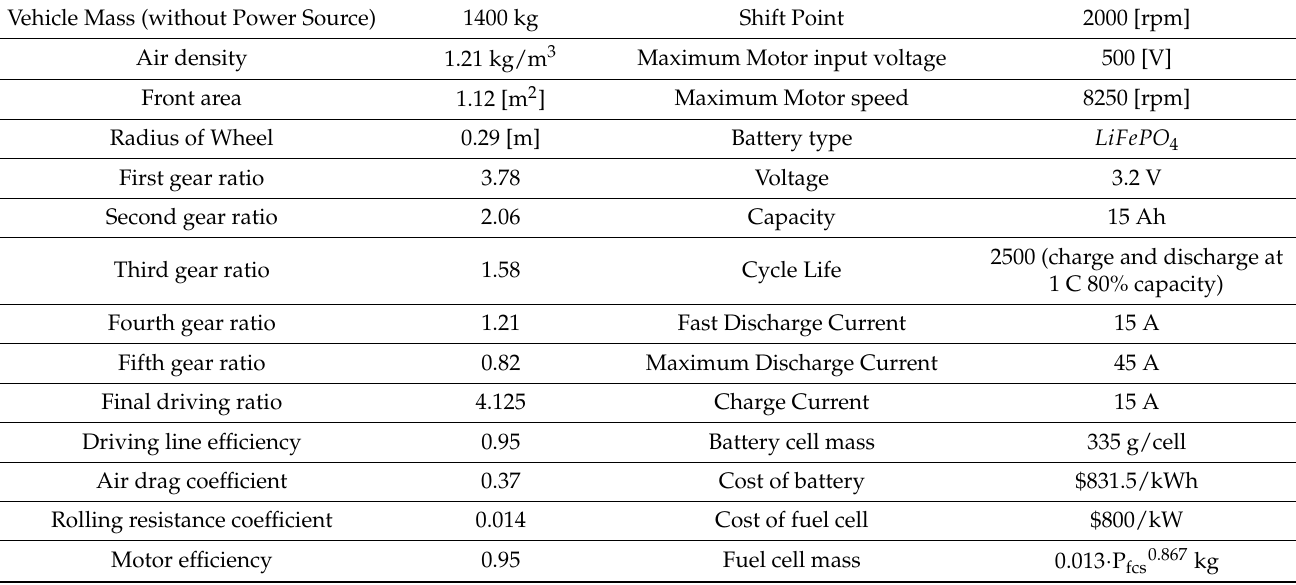
Table 1. Parameters of